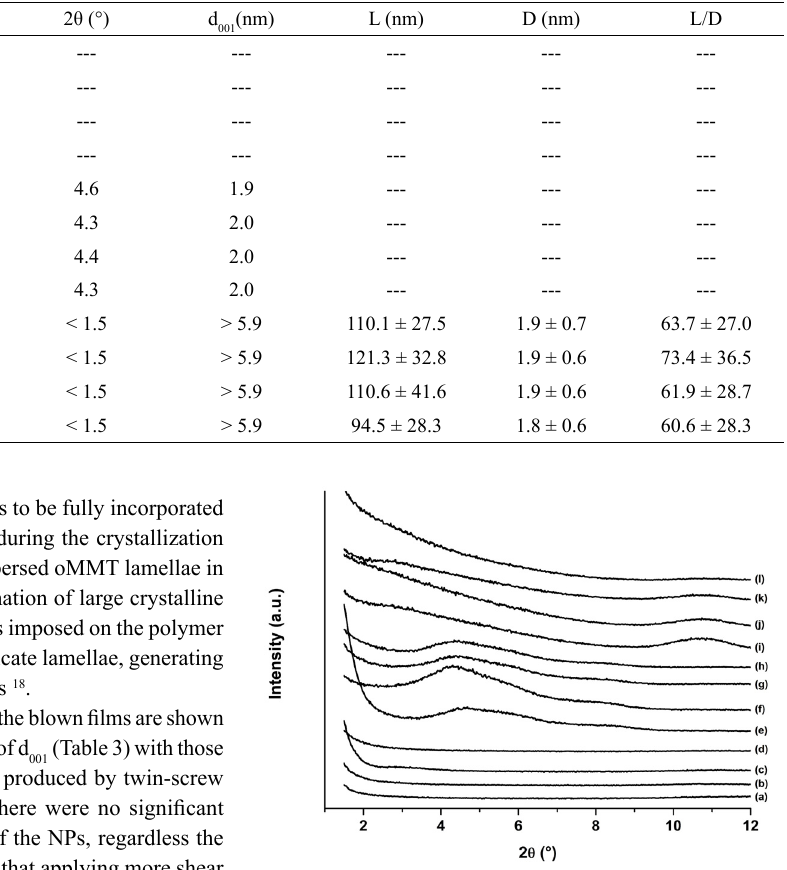
= MMT's basal spacing) and 001